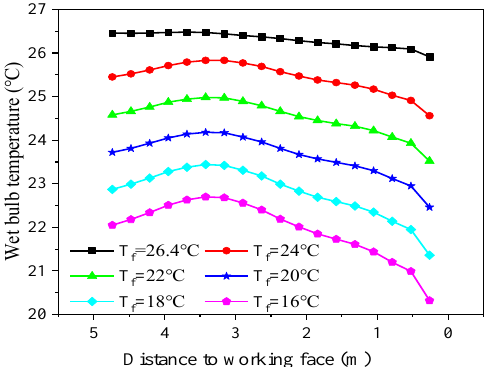
Figure 12. Wet bulb temperature distribution of drift centerline under different supply air te m per- atures.